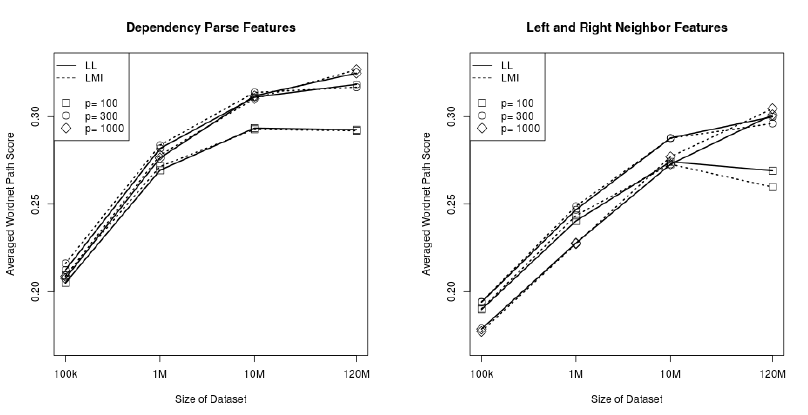
Figure 4: Corpus size vs. WordNet path similarity for different max. numbers of context features p , comparing LMI and LL measures, for two holing